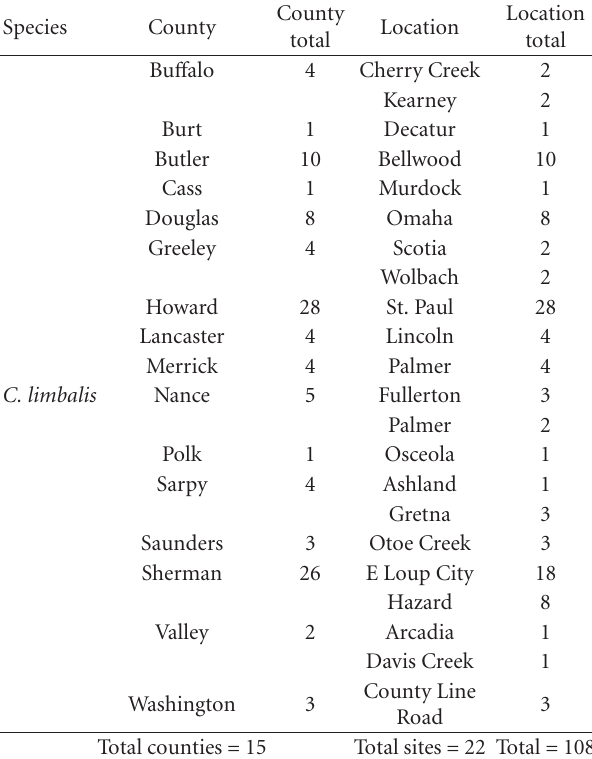
Table 2: Locality information for specimens of C. denverensis ex- amined.